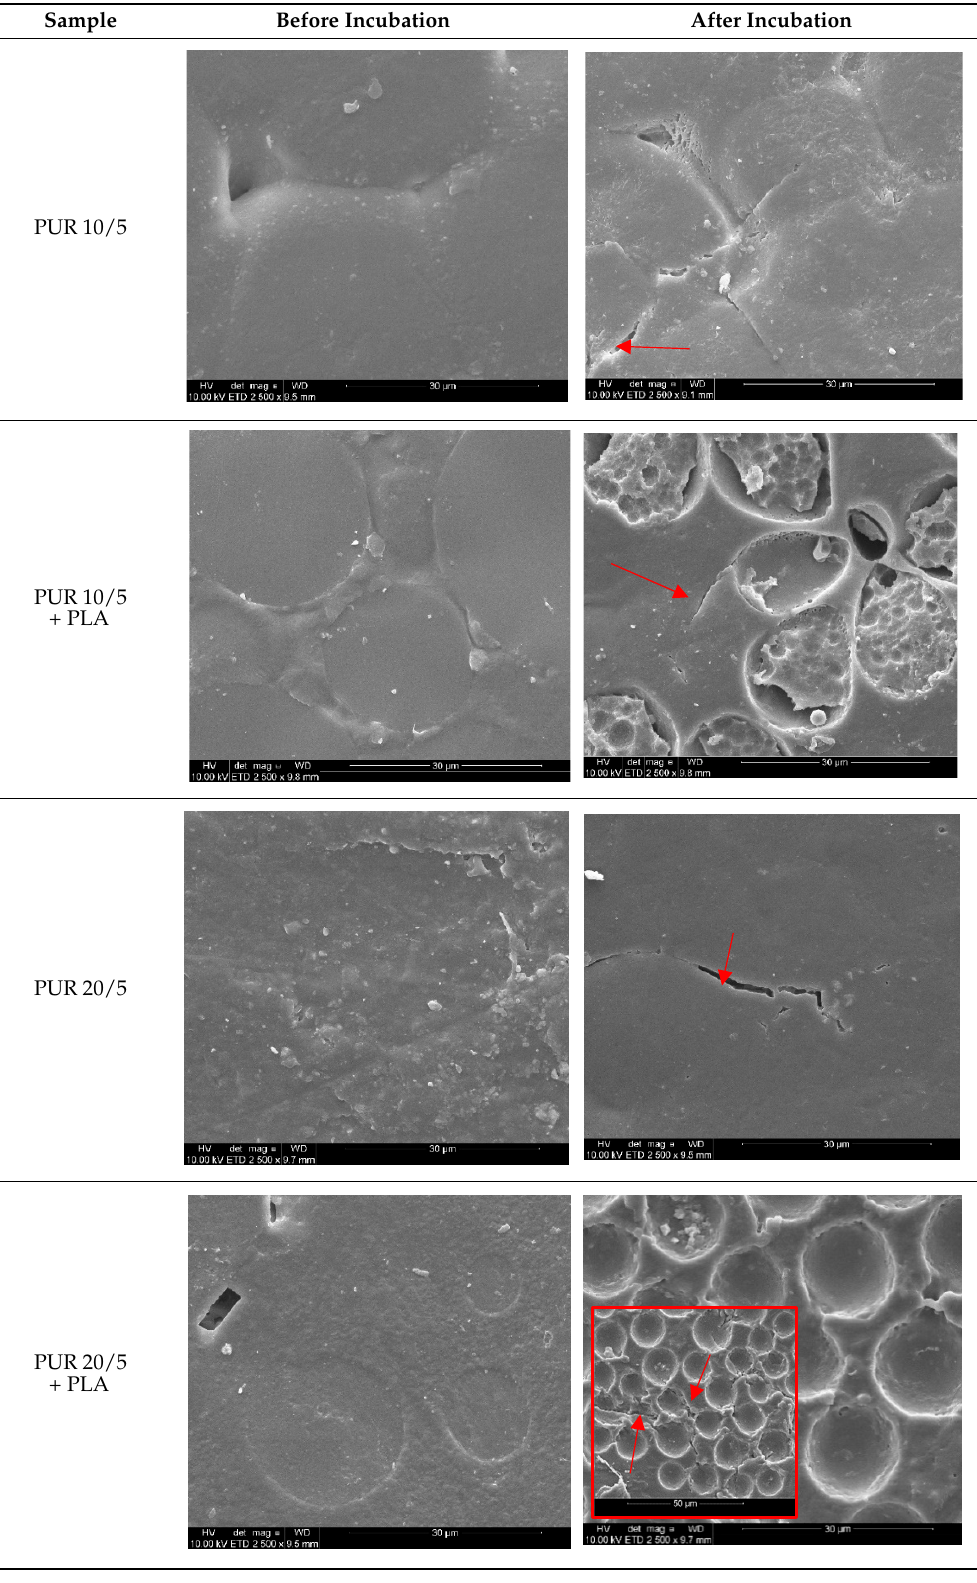
PUR 20/5 + St Red arrows indicate small cracks and holes on the surface of the incubated samples. 3.5. Changes of Thermal Properties The tested polyurethanes and their blends have low melting points of the crystalline phase of soft segments (Table 5). Instead of the expected increase in crystallinity after deg ‐ radation, a slight decrease was found. The melting enthalpies of these segments were slightly changed after sample’s exposure to soil, which indicates only slight structural changes in the polymers. This confirms the observations of the ATR ‐ FTIR and 1 HNMR spectra. Slightly lower enthalpies of PUR 20/5 and its blend, indicating lower crystallinity of these samples, may be the reason for higher degradation kinetics and higher mass loss (Figures 2 and 3) than in the case of PUR 10/5 and PUR 10/5 + PLA [25]. Table 5. Thermal properties of PURs and their blends before and after 36 weeks of exposure to soil .